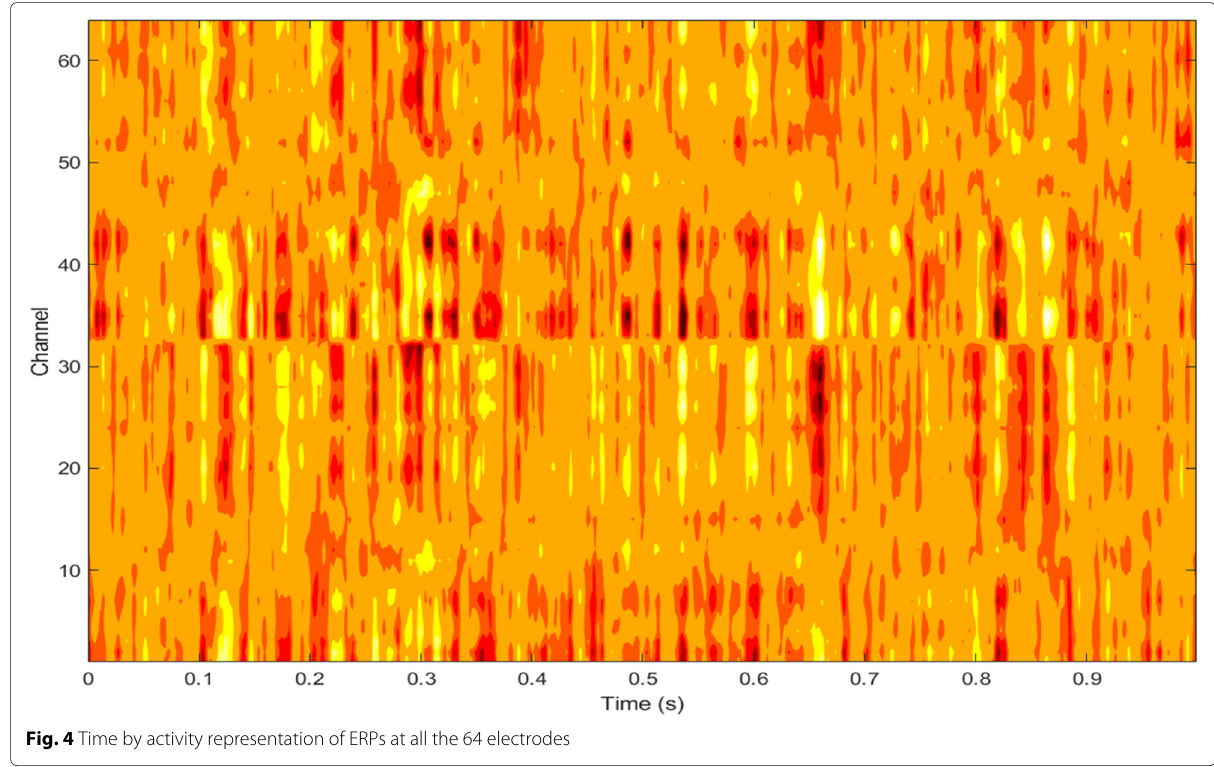
Fig. 4 Time by activity representation of ERPs at all the 64